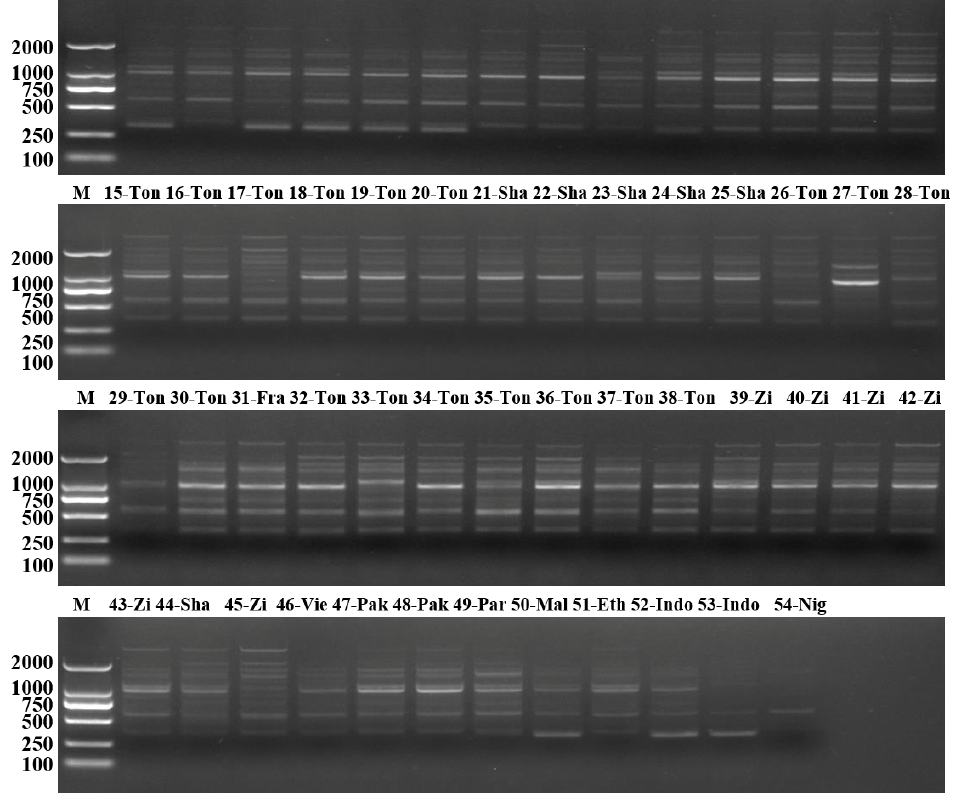
Figure 6. RAPD profiles of 54 R. communis L. seed samples amplified using primer B21. See Table 1 for the abbreviations of these 54 accessions.